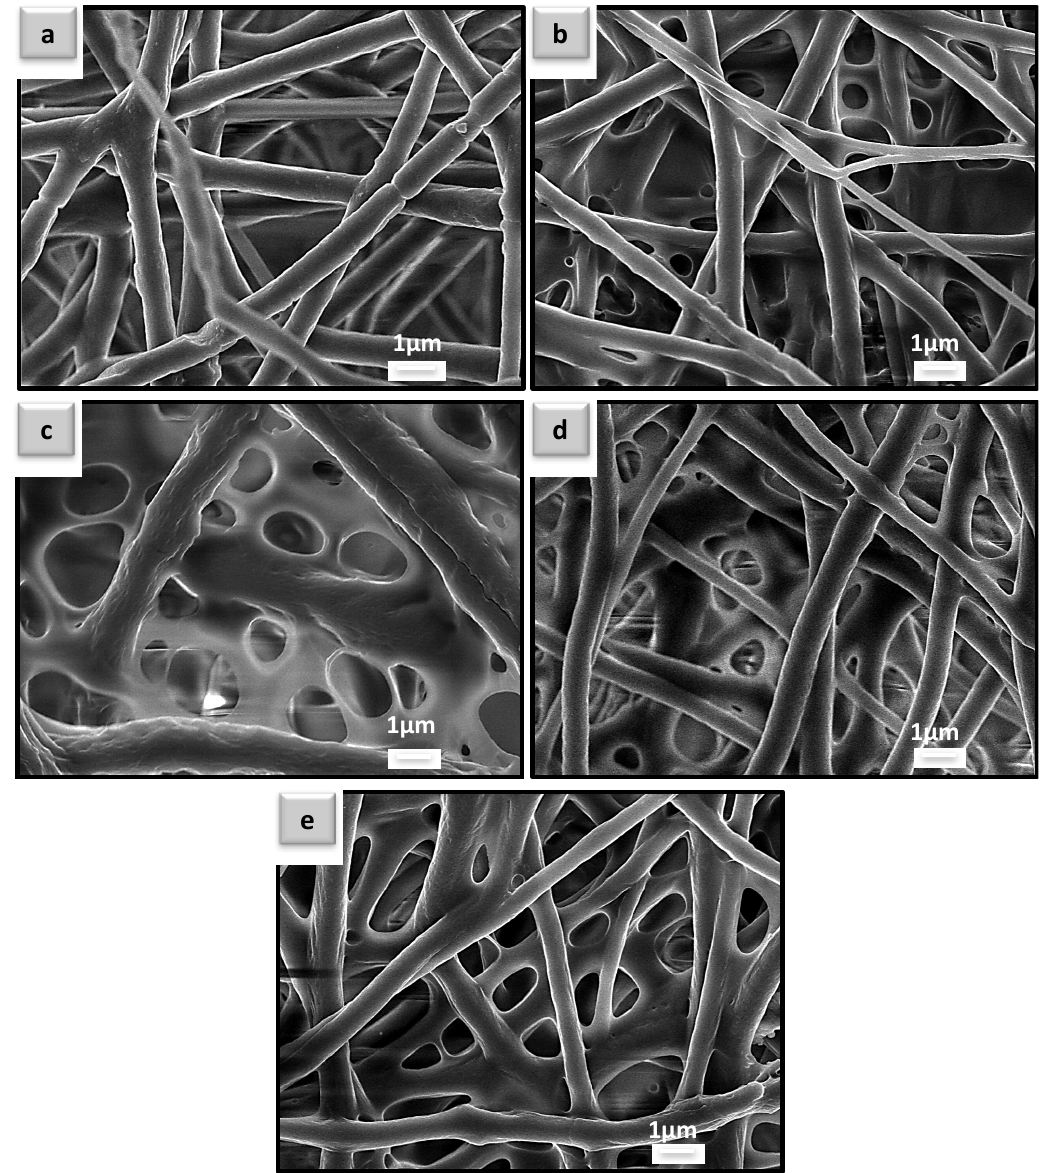
Figure A1. SEM (scanning electron microscopy) images of electrospun and coated fibers: ( a ) 3-hydroxybutyric acid-co-3-hydroxyvaleric acid (PHBV); ( b ) poly(methyl methacrylate) (PMMA); ( c ) Comp.(9:1); ( d ) Comp.(7:3); and ( e ) Comp.(5:5). Water-in-Air Contact Angle Analysis of the Uncoated and Coated PHBV Electrospun